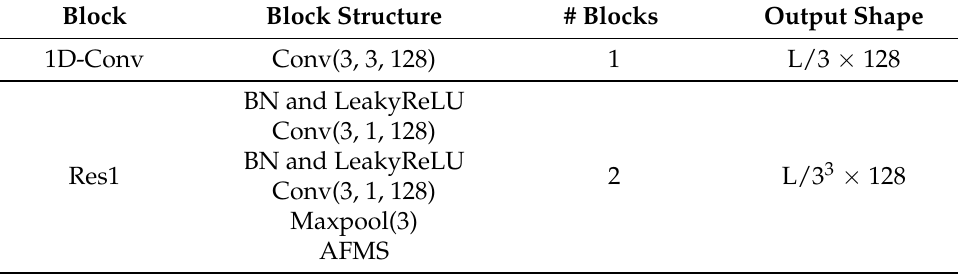
Table 1. DNN architecture of the baseline system. L is the length of the input sample. Conv refers to the convolutional layer, and Res means the residual block. For convolutional layers, numbers inside parentheses refer to the filter length, stride size, and number of filters. ASP and FC are the attentive statistics pooling and fully connected layers, respectively. AFMS represents the alpha feature map scaling module, proposed by